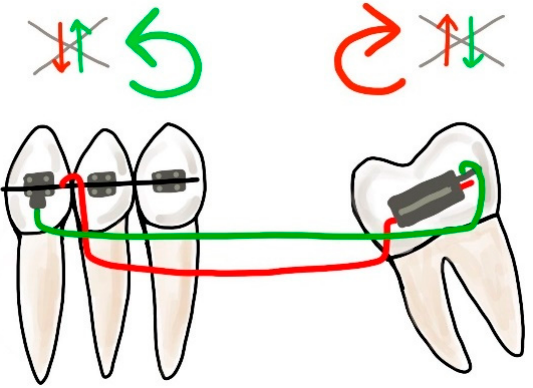
Figure 13. Double cantilever mechanics. The red cantilever, from the molar to the anterior teeth, generates extrusion, clockwise rotation on the molar, and intrusion on the anterior teeth (red arrows). In order to control the vertical forces, a second cantilever, from a tube in the anterior, is required. This green cantilever is placed distally to the molar and it produces molar intrusion and a counter-clockwise movement with extrusion on the anterior teeth (green arrows). The resultant forces cancel each other, and two opposite moments occur.